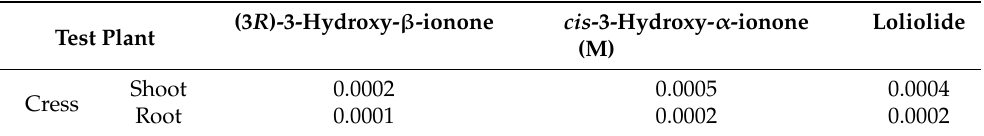
Figure 5. The phytotoxicity of compound loliolide against cress. Values indicate means ± SE from three replications ( n = 30). Significant variations between control and treatment are indicated by various letters ( p < 0.05–0.001). Table 2. The concentrations required for 50% growth inhibition (I 50 value) of the cress seedlings by the identified compounds from the Elaeocarpus floribundus leaf